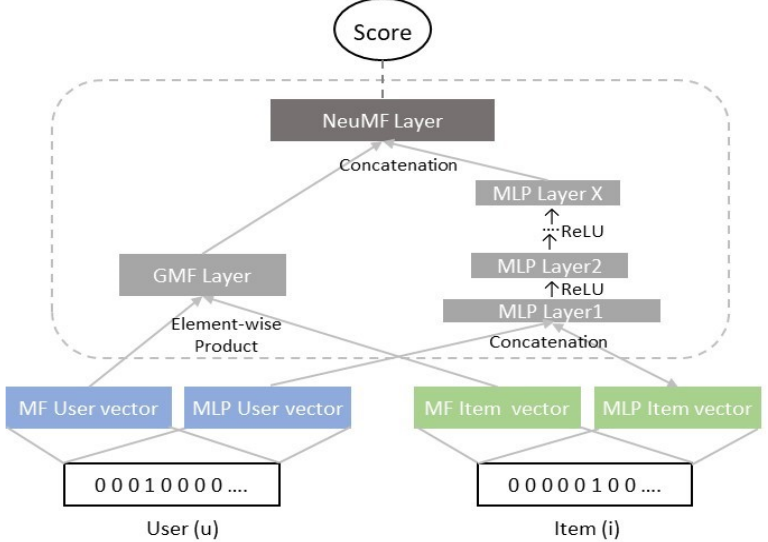
Figure 2. Structure of Neural Collaborative Filtering.